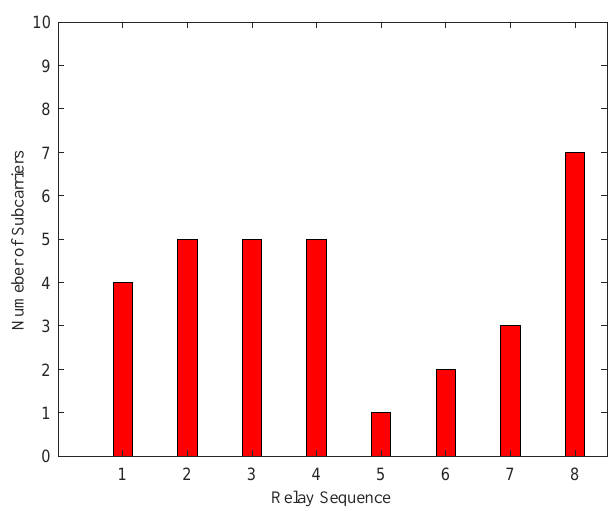
Figure 8. Subcarrier allocation for signal forwarding in the second